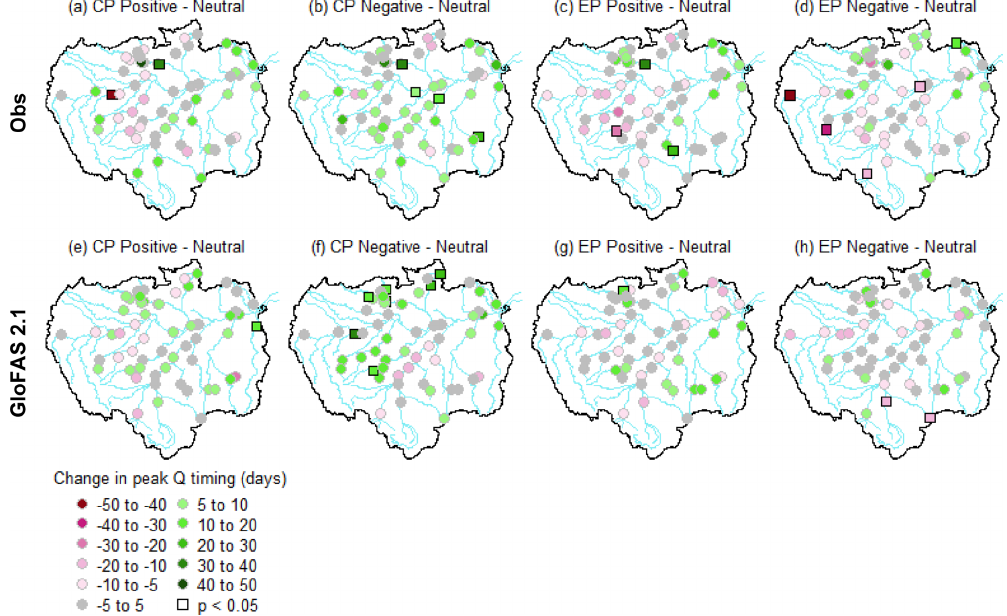
Figure 6. Average change in the timing of observed and simulated annual peak river flows between different phases of the CP and EP indices. (a, c, e, g) Positive with respect to neutral years. (b, d, f, h) Negative with respect to neutral years. Panels (a–d) represent changes for observations and panels (e–h) show changes for GloFAS 2.1 streamflow reanalysis data. Pink (green) points represent where flood peaks occur earlier (later) compared to neutral conditions. Significant results at the 95% confidence level are denoted using a square (i.e. p < 0 .